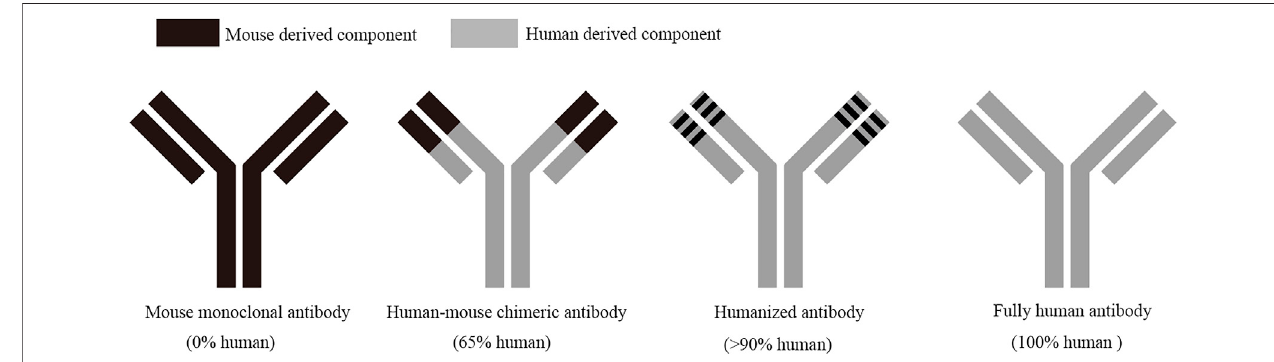
FIGURE 1 | Development process of recombinant antibody drugs. Mouse monoclonal antibodies are all mouse-derived components, with large side effects and high immunogenicity; human-mouse chimeric antibodies are 65% human-derived components, with lower side effects than mouse monoclonal antibody; human- derived components in humanized antibodies are over 90%, with mild side effects and very low immunogenicity; fully human antibodies are all human-derived components, which can obviously remove the immunogenicity and side effects, and with good therapeutic